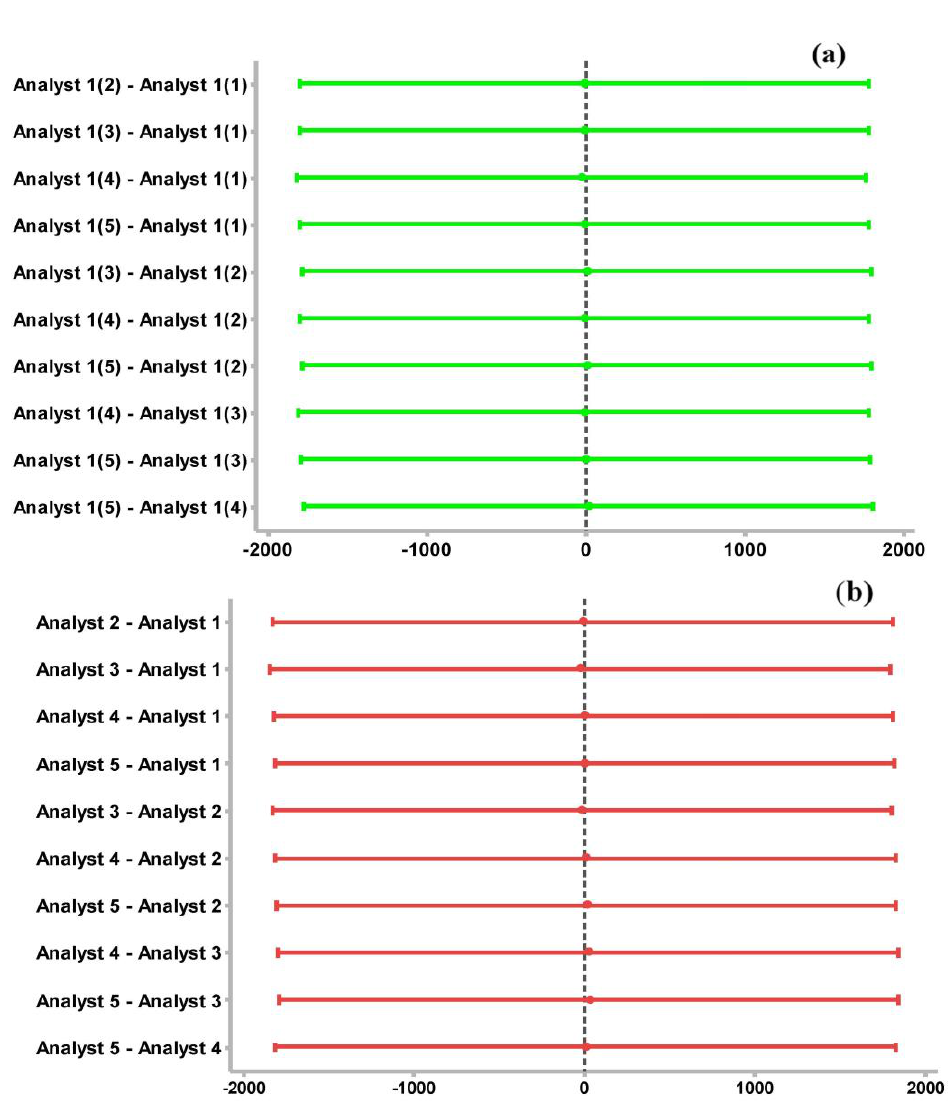
Figure 6. ( a ) Difference of means compared one to one for SPE repeatability. ( b ) Difference of means compared one to one for reproducibility of SPE. Table 3. Quantification of Irgafos 168 in wastewater